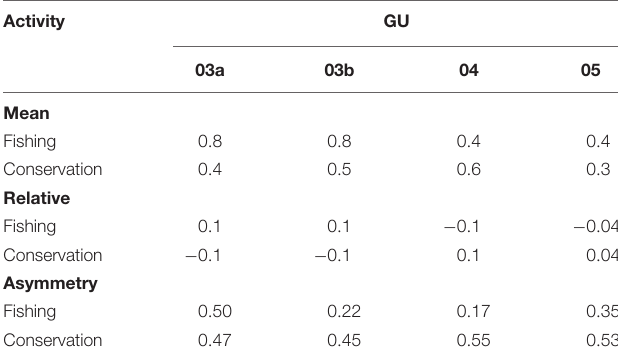
TABLE 3 | Mean suitability, relative suitability, and asymmetry index results for the environmental management units (EMU) in the Gulf of